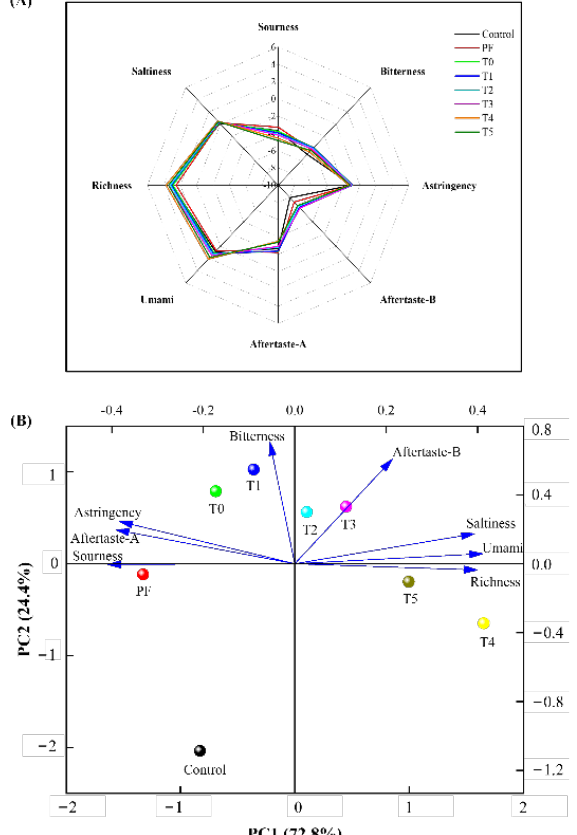
Figure 3. Radar chart ( A ) and principal component analysis ( B ) of the electronic tongue data for phosphate-containing frankfurters or phosphate-free frankfurters added with the combination of L-Arg and PC. PF group: no added phosphate. T0 group: 0.15% PC and no added phosphate. T1 group: 0.15% PC + 0.025% L-Arg, and no added phosphate. T2 group: 0.15% PC + 0.05% L-Arg, and no added phosphate. T3 group: 0.15% PC + 0.075% L-Arg, and no added phosphate. T4 group: 0.15% PC + 0.1% L-Arg, and no added phosphate. T5 group: 0.15% PC + 0.125% L-Arg, and no added phosphate.